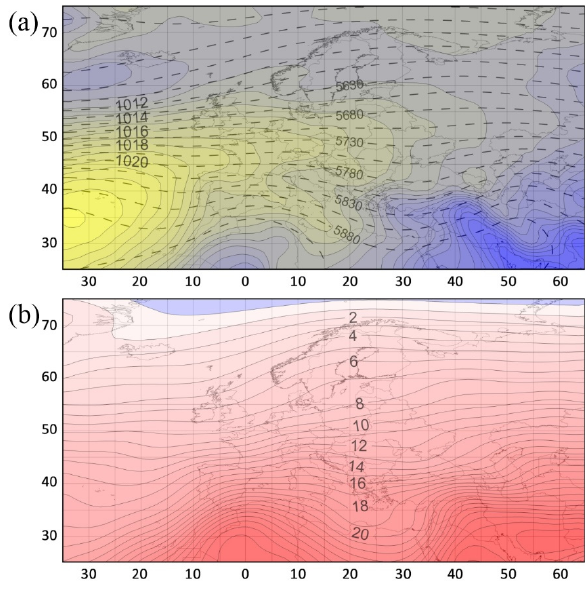
Figure 5. Mean summer (June–August) ( a ) SLP in hPa (colour scale) and z500 hPa in gpm (dashed lines) and ( b ) T850 in °C.